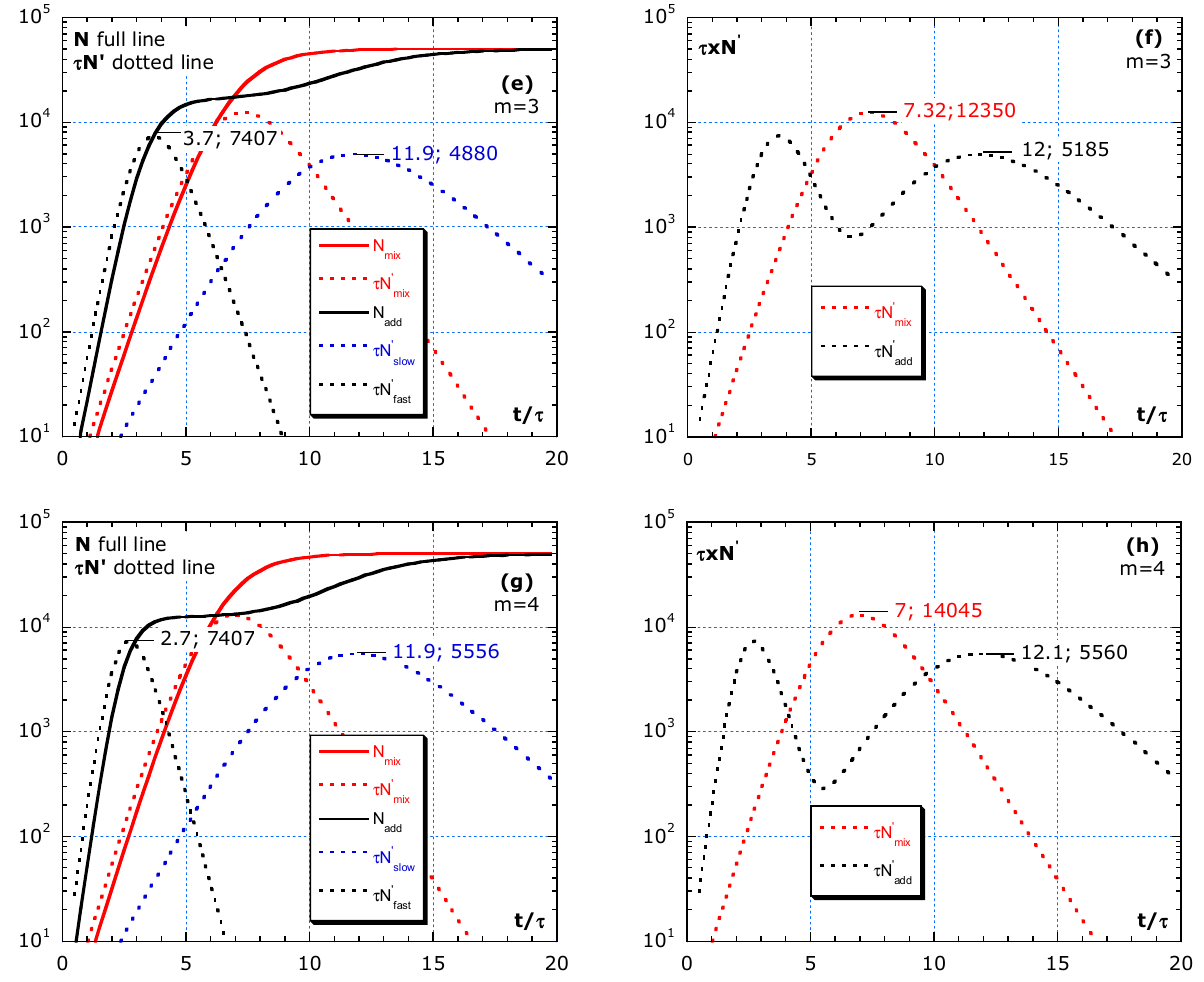
Figure 5. Difference between adding and mixing without a change in parameters: τ and M during the outbreak. ( a , b ) Shows almost homogeneous, with m = 3/2. ( c , d ) Simulations with m = 2, representing subgroups equal in number. ( e , f ) Simulation with m = 3 and ( g , h ) simulation with m = 4. The fast group gives an earlier, sharper and higher peak than the slow group. Mixing always results in a higher and sharper peak than adding. Improving isolation by, e.g., avoiding social gatherings, specifically, between fast and slow groups, is more efficient than by strengthening general rules.